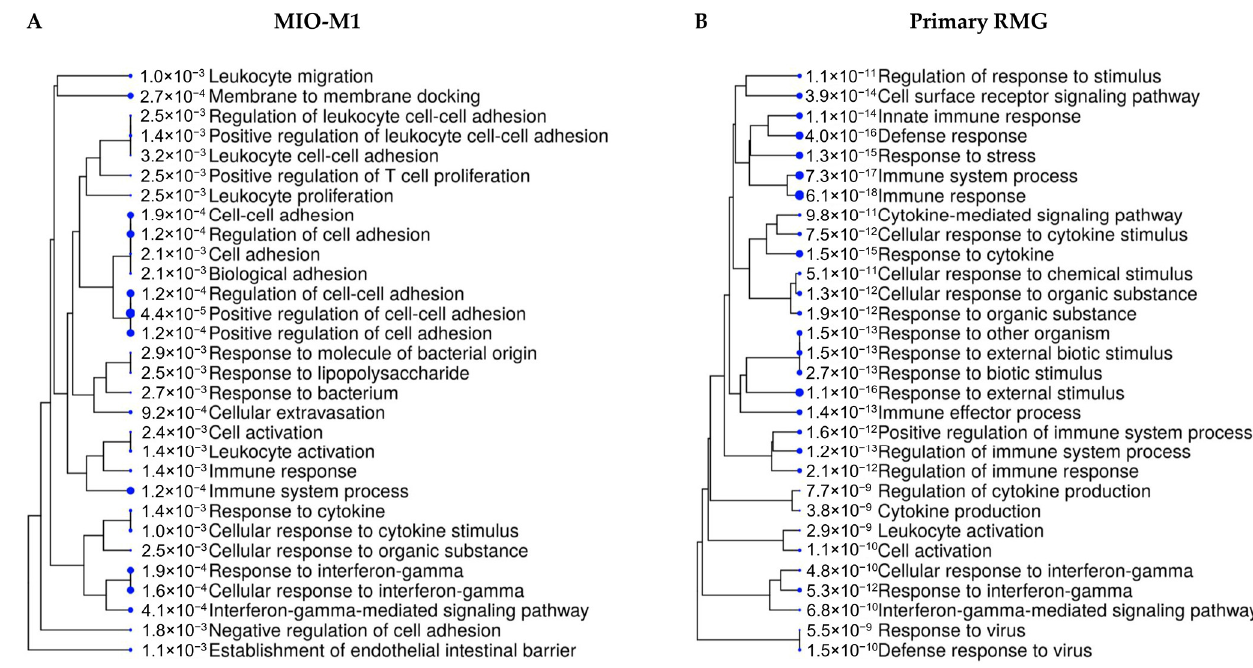
Figure 2. Shiny GO enrichment tree showing the 30 most significantly enriched functional categories from biological processes after LPS stimulation in ( A ) MIO-M1 cells and ( B ) primary RMG. Pathway enrichment analyses were performed with human orthologue gene names of proteins with significantly higher abundance in stimulated state. Size of the solid blue dots corresponds to the enrichment FDR with bigger dots indicating more significant p -values. Pathways with many shared genes are clustered together. Gene names of the proteins which clustered to respective pathways are given in Supplementary Table S3.